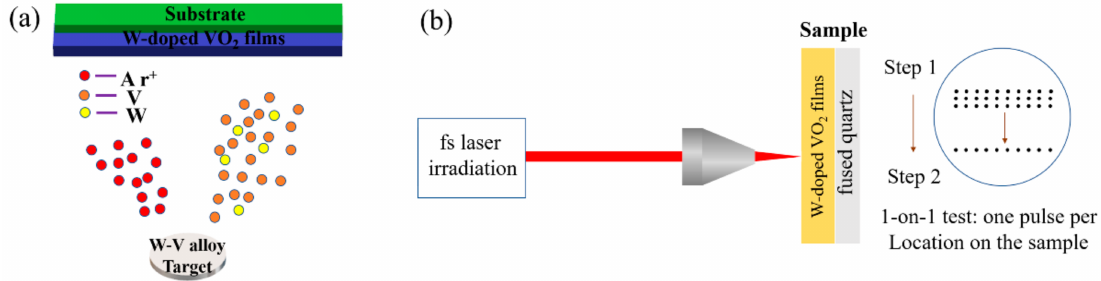
Figure 1. ( a ) Schematic of the DC magnetron sputtering system and vanadium-tungsten alloy target. ( b ) Schematic of the setup for the fs-laser damage tests.